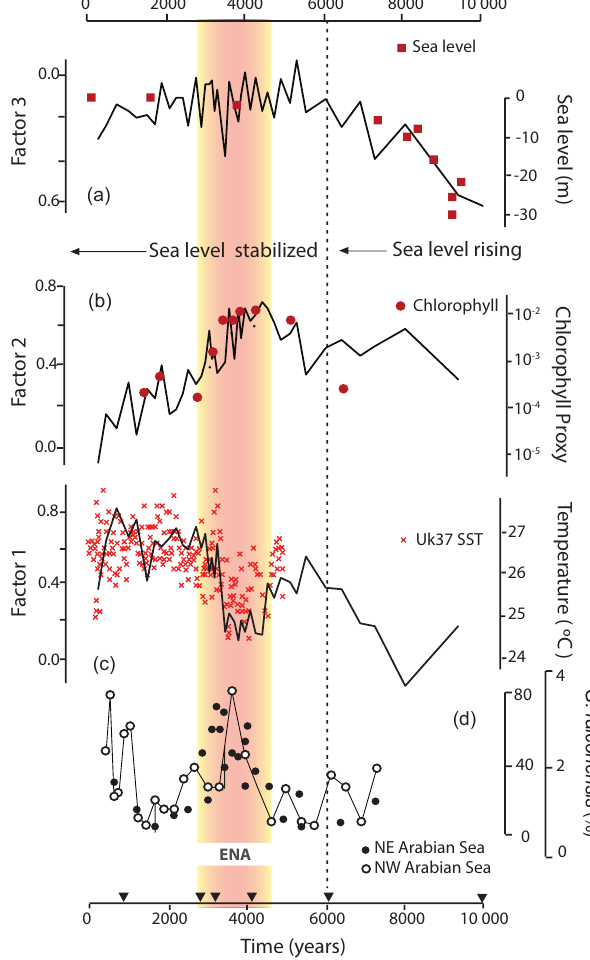
Figure 4. Holocene variability in plankton communities as reflected by their sedimentary DNA factor loadings ( a – c ) and winter mixing- sensitive percentage G. falconensis (d) in core Indus 11C in the northeastern Arabian Sea. Relative chlorophyll biosynthesis pro- teins abundances are also shown. Sea level points are from Camoin et al. (2004); SSTs are from Doose-Rolinski et al. (2001); and G. falconensis census from the northwestern Arabian Sea is from Schulz et al. (2002). Triangles show radiocarbon dates for core In- dus 11C. The period corresponding to the early neoglacial anoma- lies (ENA) is shaded in red hues.